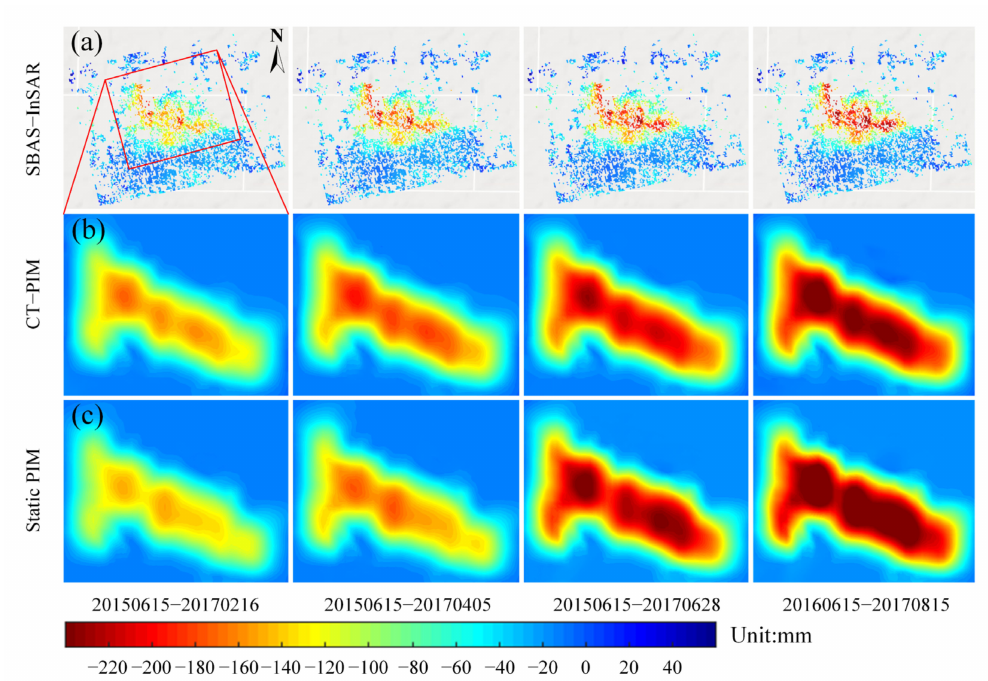
Figure 15. Subsidence comparison: ( a ) SBAS-InSAR results; ( b ) CT-PIM predicted; ( c ) static PIM predicted (with reference to 15 June 2015).